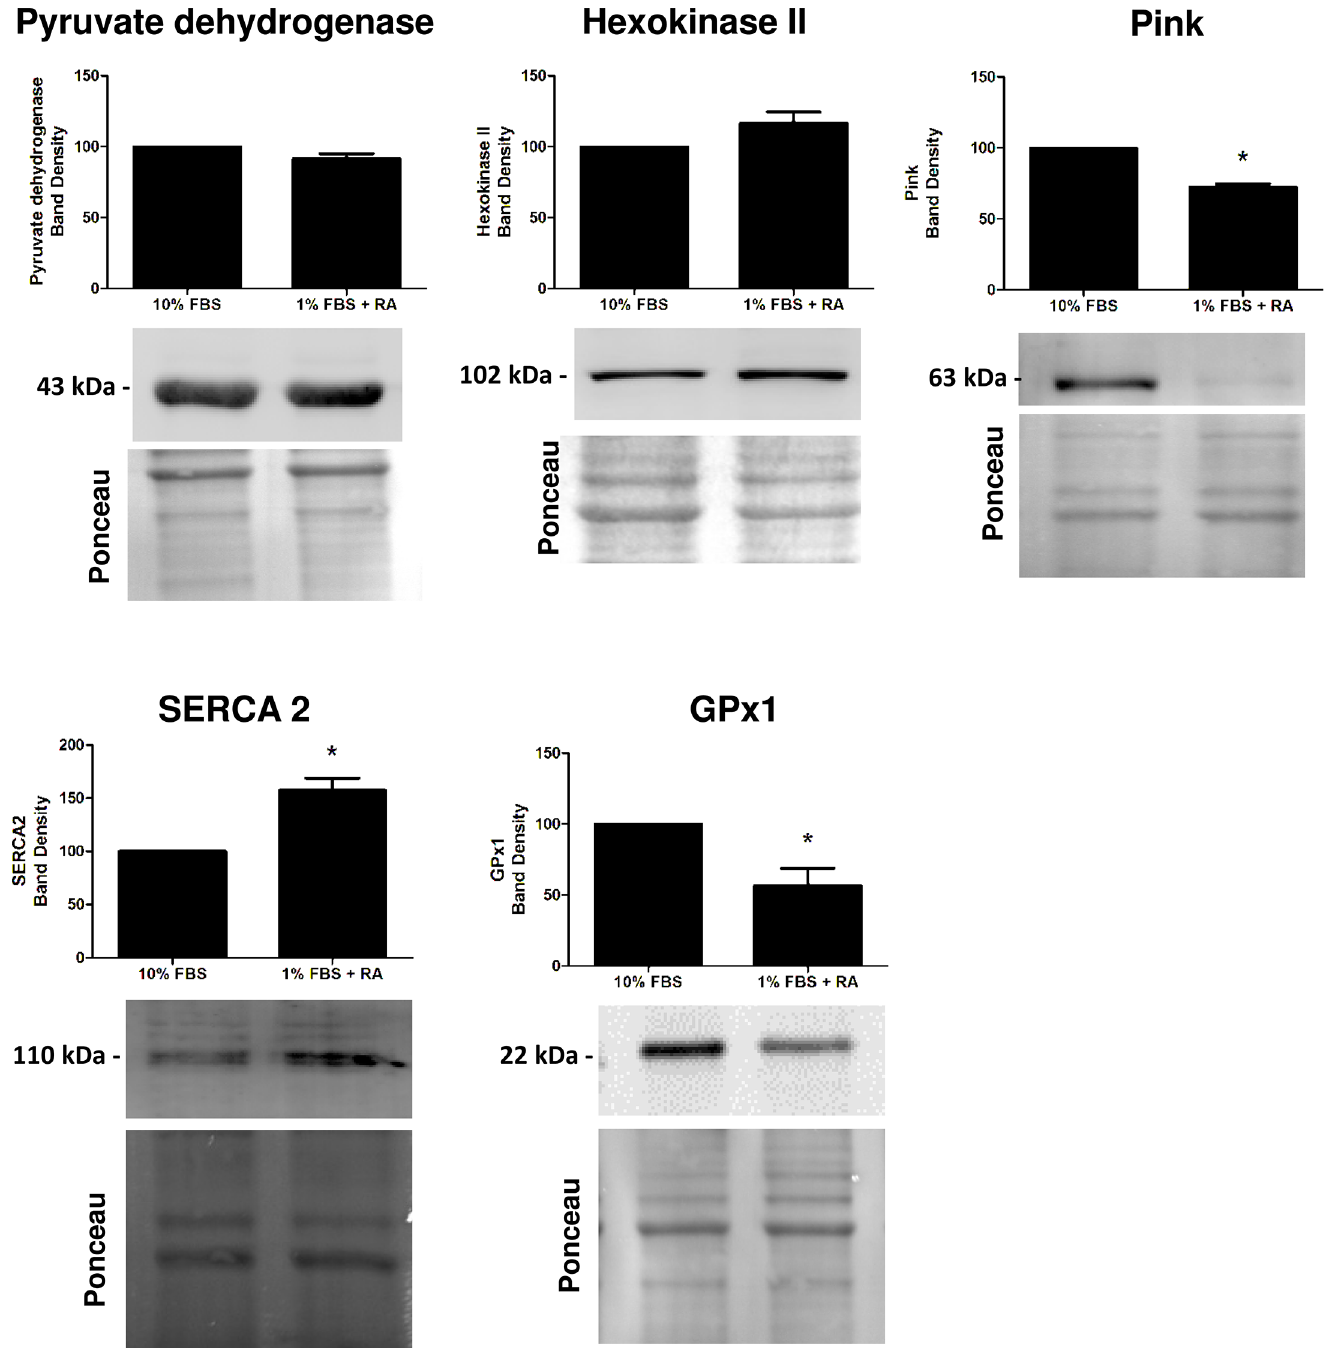
Fig 3. Semi-quantification of selected proteins involved on calcium handling and metabolism by Western blotting. Protein content of pyruvate dehydrogenase, hexokinase II, Pink, SERCA2 and glutathione peroxidase 1 was measured by Western blotting as described in the materials and methods section. H9c2 myoblasts were differentiated by being cultured in 1% FBS medium supplemented with 1 μ M RA and maintained for 5 days. Total extracts from both cellular groups were collected. Ponceau labeling represents the loading control and was used to normalize data. Data represent the mean ± SEM of 4 independent experiments ( * ) p < 0.05 versus undifferentiated